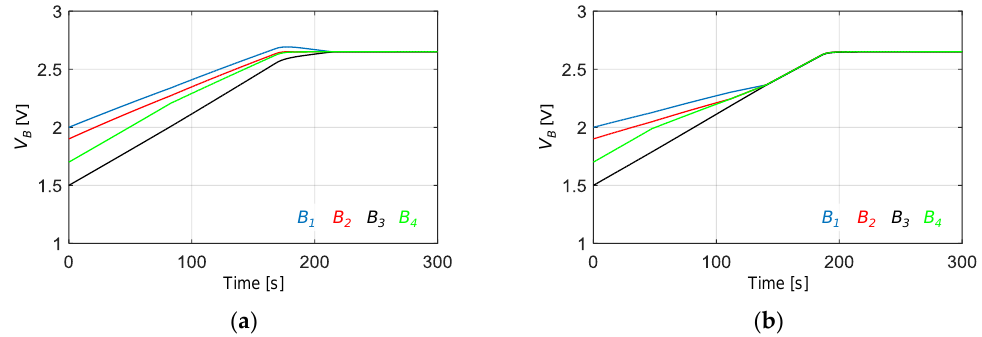
Figure 12. EDLC cell voltage, charged by the CC-CV charger with the cells-to-string balancer altered from the MISO SC converter; ( a ) with a non-tapped inductor and a 0.9 duty cycle for Q 1 ; and ( b ) with a tapped inductor.